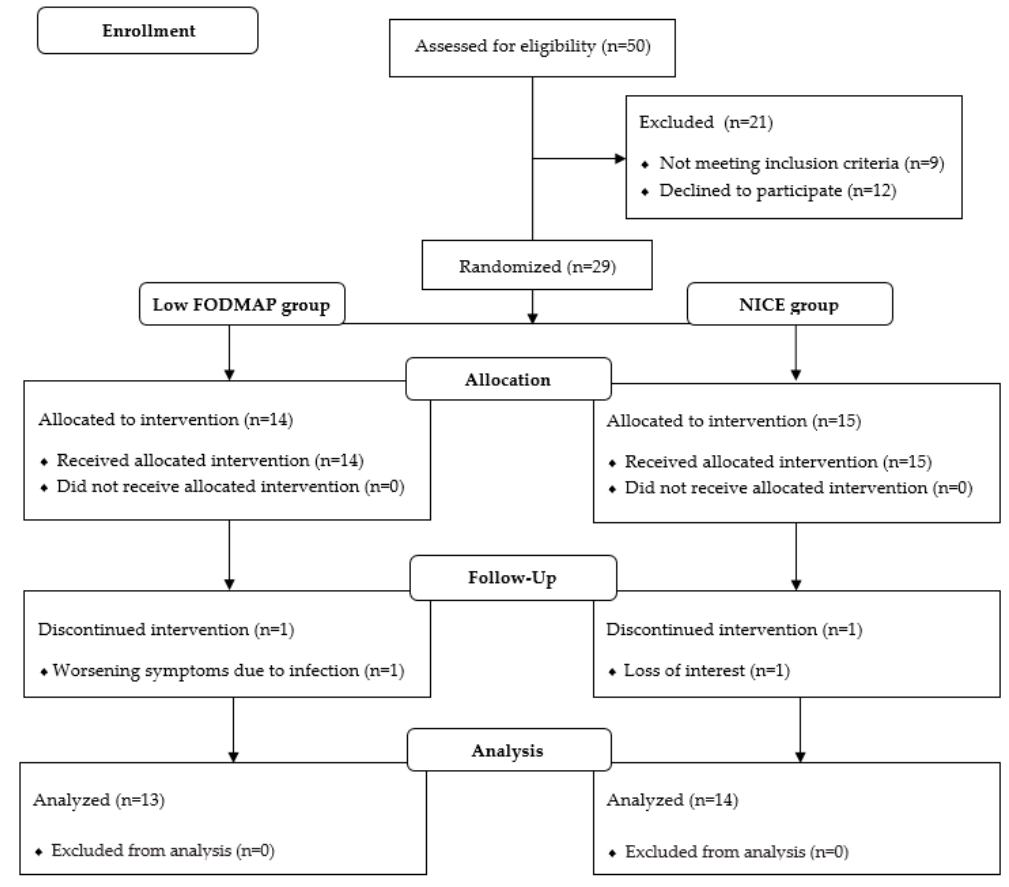
Figure 1. Diagram of the enrolment, randomization, and study allocation.